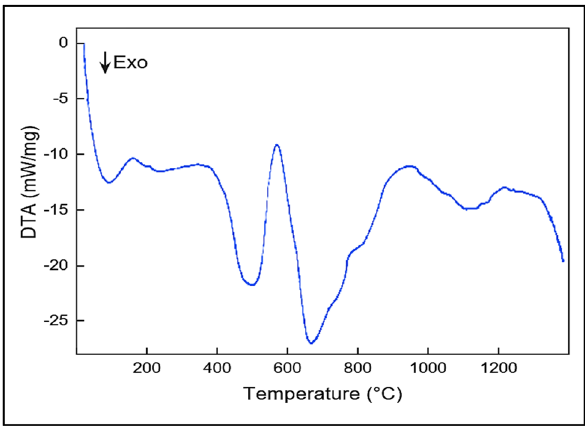
Figure 6: Di ff erential thermal analysis thermogram of